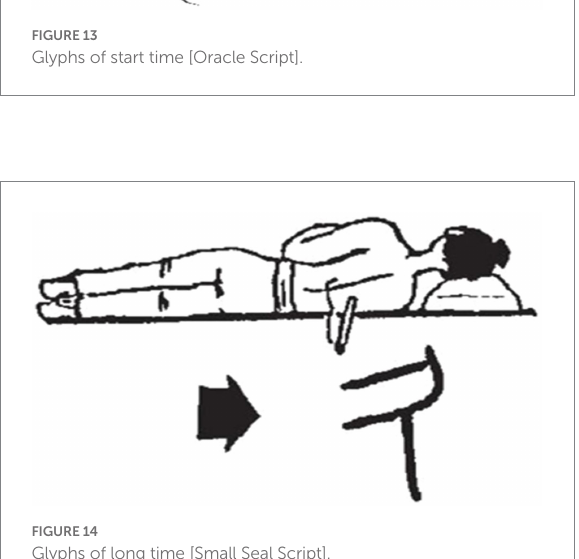
FIGURE 14 Glyphs of long time [Small Seal